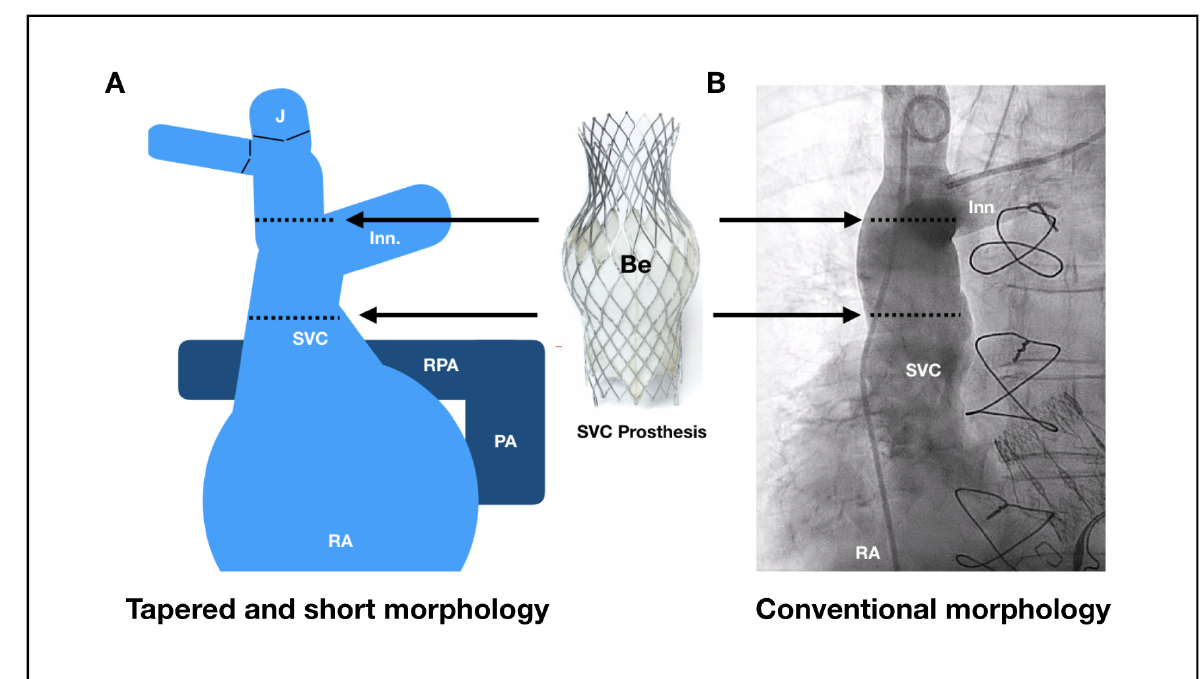
Figure 2. Anatomical diagram and angiographic view of superior vena cava. ( A ) Anatomical diagram of a tapered and short superior vena cava (SVC). The morphology of the superior vena cava showed in the diagram increases the risk of prosthesis migration/embolization into the right atrium (RA). A high implantation is thus recommended to prevent it (target position is to implant the belly part of the SVC prosthesis at the level of the innominate plane without obstructing the ostium). ( B ) Angiographic view at posterior-anterior plane showing a SVC with conventional morphology. In these cases target position is to place the belly part of the SVC prosthesis at the level where the right pulmonary artery crosses the SVC. Be: Belly part of the superior prosthesis. J: common Jugular vein. Inn: Innominate vein. PA: Pulmonary Artery. RA: Right Atrium. RPA: Right Pulmonary Artery. SVC: Superior Vena Cava. T: Tricuspid Valve.